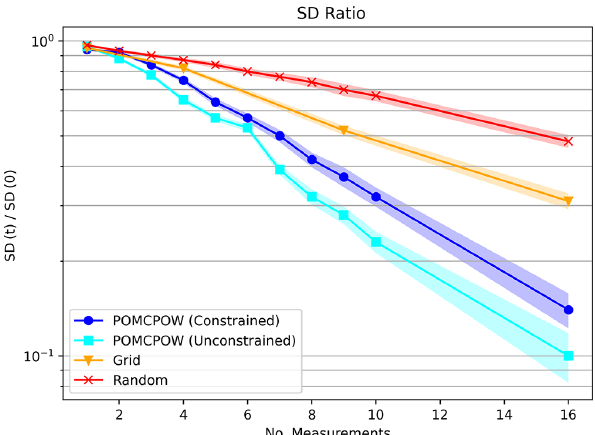
Figure 26. Two-mineralization-process standard deviation ratios. The plot shows the mean standard deviation ratio after a given num- ber of measurements taken under each tested method. The mean ratio is shown along with 1 standard error bounds for each